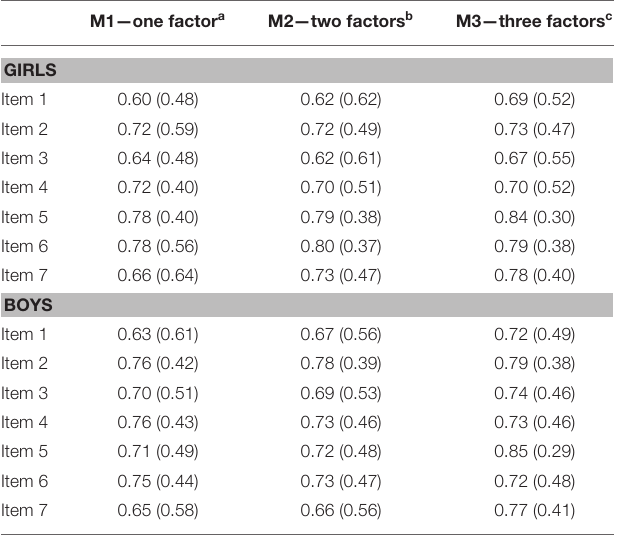
TABLE 5 | Model factor loadings and residual variances (in parentheses) for gender groups for three tested